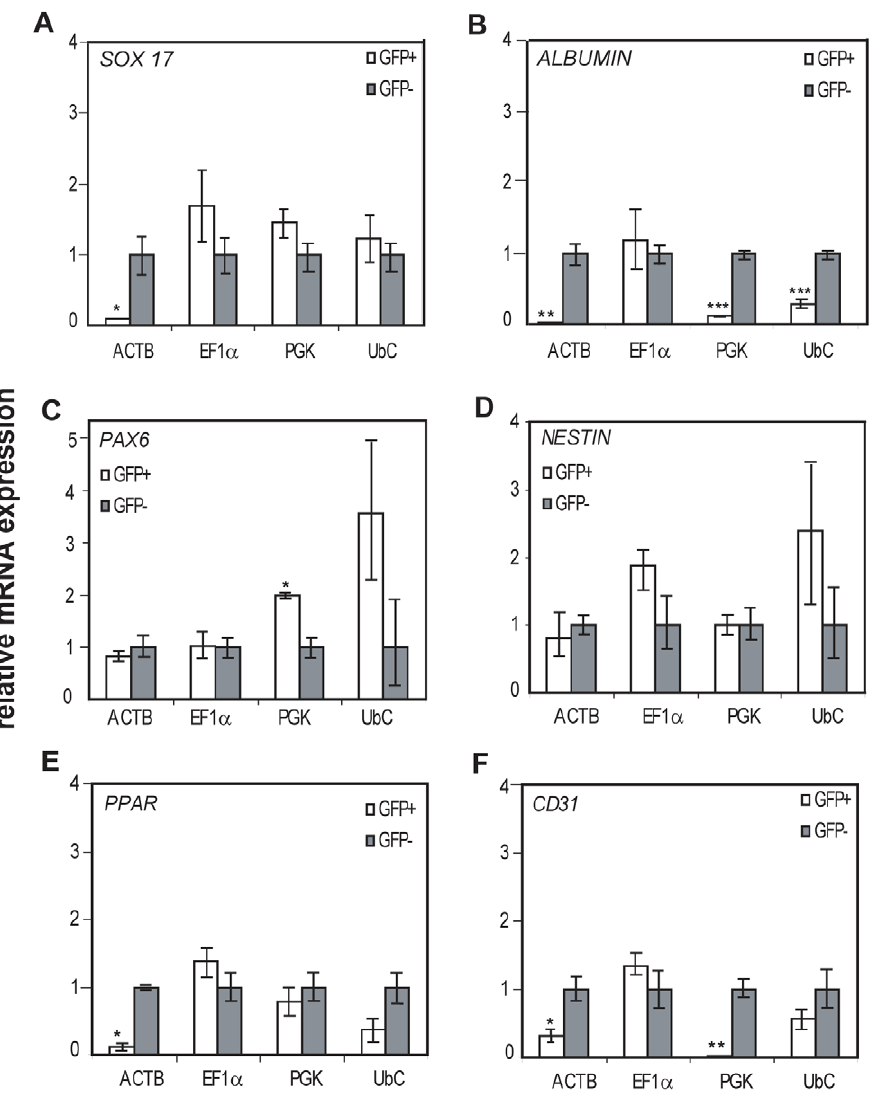
Figure 4. Activity of promoters in cell types representing all three embryonic germ layers. hESCs were spontaneously differentiated for 22 days and thereafter separated by FACS sorting into the eGFP + and eGFP 2 cell populations. Relative gene expression was performed by qPCR on the eGFP + and eGFP 2 populations. A – F. Expression analysis of genes representative for differentiation to the three embryonic germ layers; endoderm, mesoderm and ectoderm. SOX17 ( A ) and ALBUMIN ( B ) originates from endoderm. Neural progenitors PAX6 ( C) and NESTIN ( D ) originates from ectoderm. E–F. Mesodermal cells; PPAR c ( E ) and CD31 ( F ). Expression levels for each gene in eGFP + and eGFP 2 populations are plotted as relative to expression levels in undifferentiated hESCs. Results are plotted as mean of three independent experiments and error bars indicate 6 s.d. Statistical analysis of GFP + cells compared to GFP 2 cells determined by students t’test (p* # 0,0392).